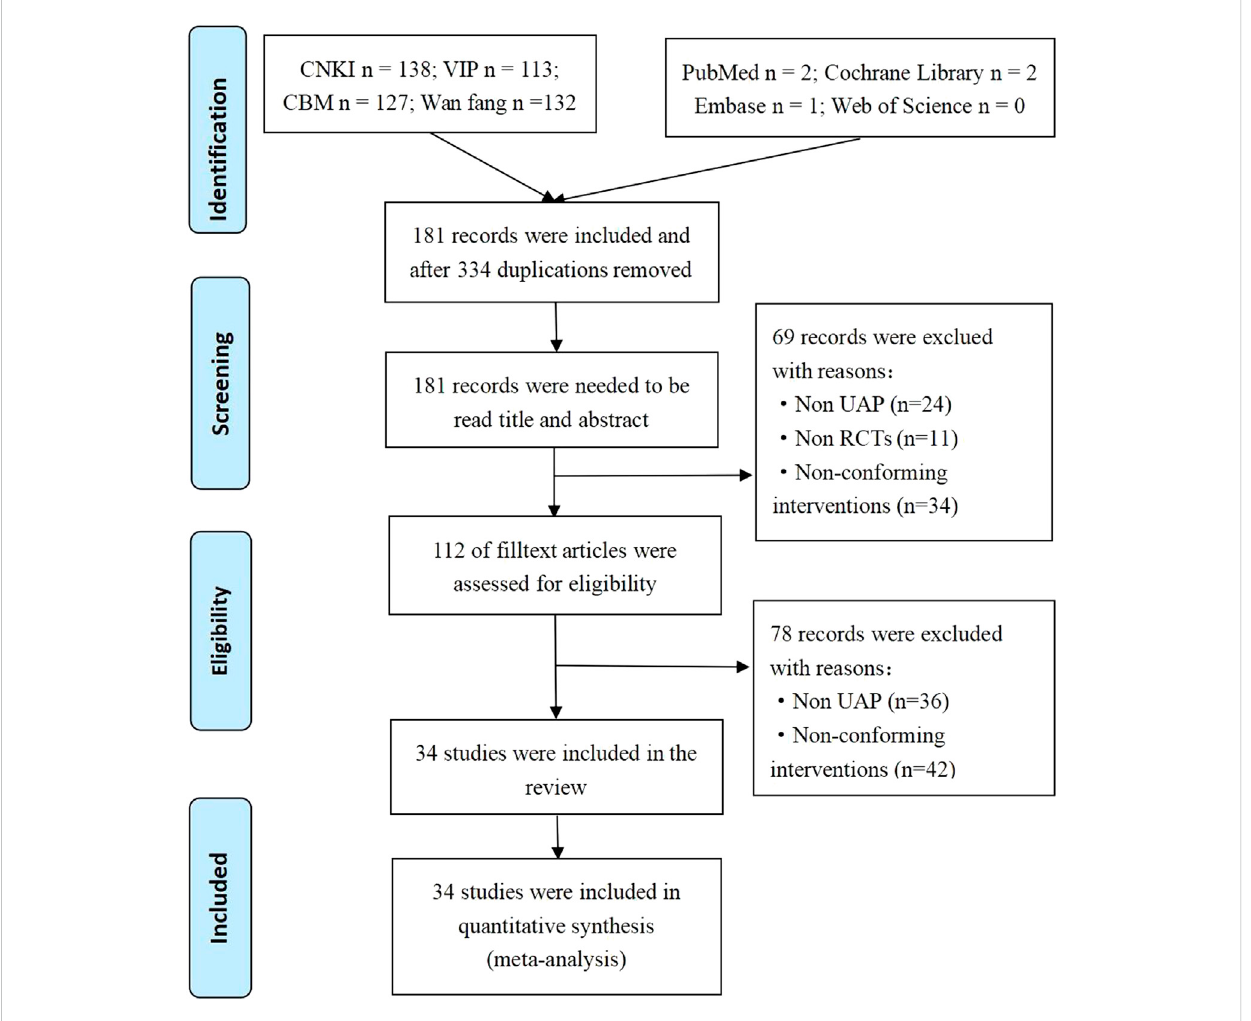
FIGURE 1 Flowchart of article selection